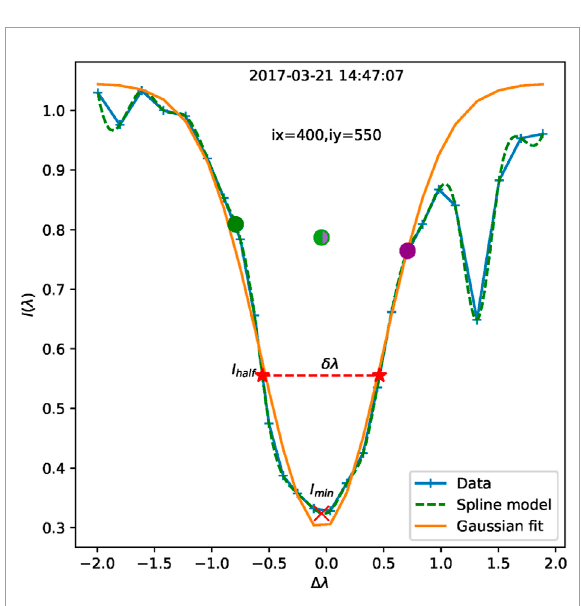
FIGURE 2 Example calculation of the H α line width. The x -axis is wavelength in Å from the nominal line core, while the y -axis is the profile intensity, normalized to the maximum of the average profile over the whole sample. This figure is reproduced from Kobelski et al. (2022) by permission of the AAS.